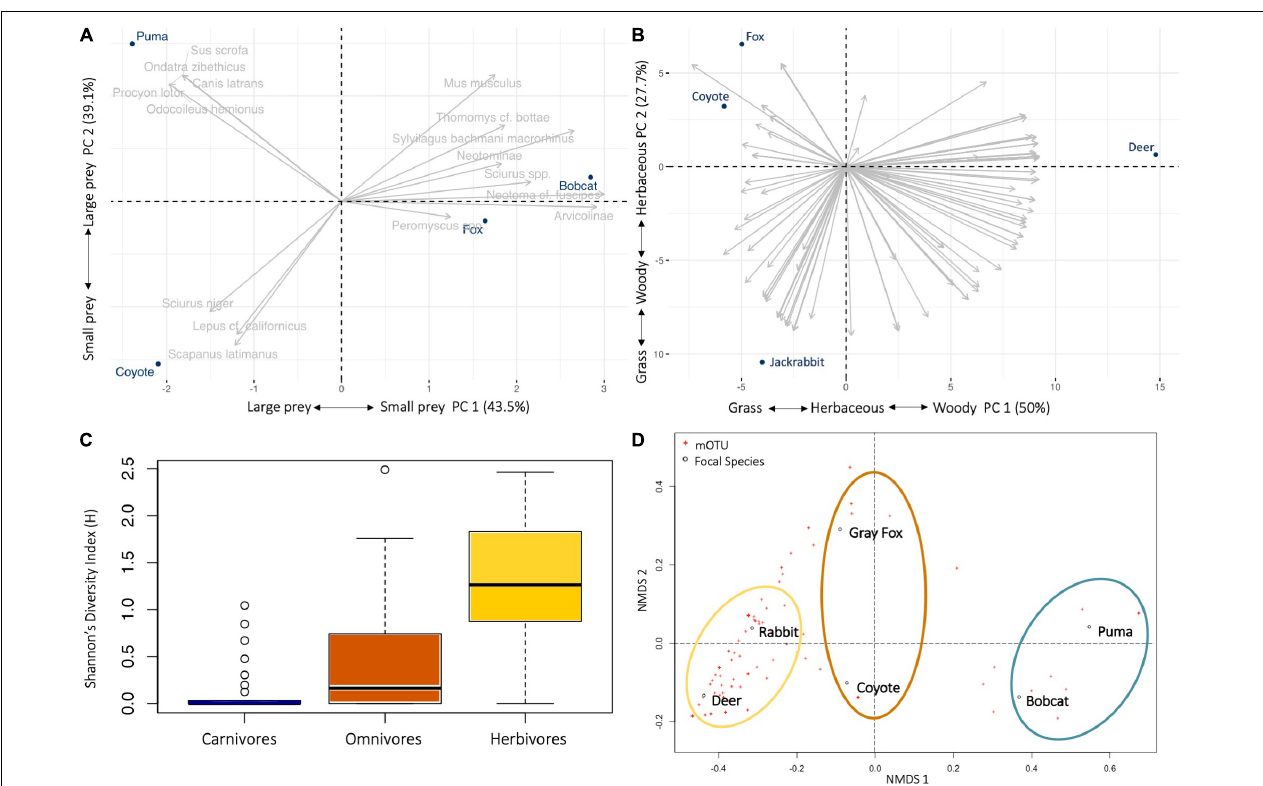
FIGURE 2 | Diet ecology of six mammal species on Jasper Ridge Biological Preserve. Principal component analysis (PCA) biplot of the mammal ( n = 16) and plant ( n = 196) taxa frequency of occurrence within fecal samples of the (A) predators (puma, coyote, bobcat, gray fox), showing the position of consumer in relation to the different prey items; and (B) herbivore (deer, jackrabbit) and omnivore (coyote, gray fox) (taxa names removed for clarity). Explained variances of the two principal components are shown in brackets. (C) Box-plots alpha diversity indices of Shannon diversity ( F 2 , 110 = 29.65, p < 0.0001) in diet across fecal samples from the carnivore, omnivore and herbivore trophic level in JRBP. Lines in boxes are medians, box ends are quartiles, whiskers show ranges, and o indicates outliers. (D) Patterns of niche space across the six different focal species using non-metric multidimensional scaling (nMDS) for Bray-Curtis dissimilarity of frequency of occurrence data showing dissimilarity of carnivore (blue), omnivore (orange), and herbivore (yellow) diets. The distance between points represents the level of difference. The closer the species in the graph, the higher their